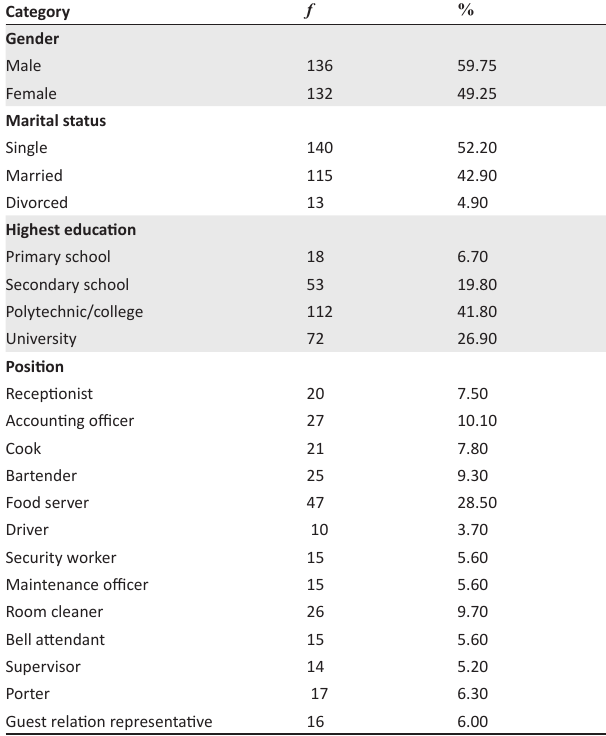
TABLE 1: Characteristics of participants ( n =